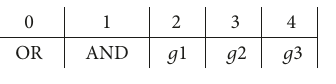
Figure 2: Single metagene